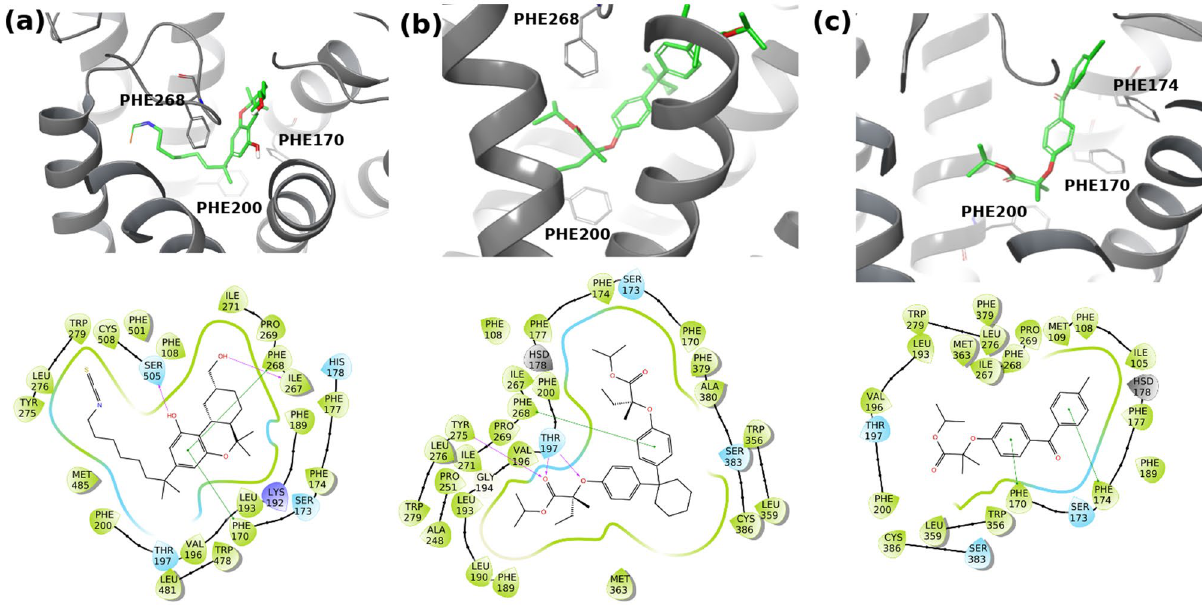
Figure 7. The 3D (upper panel) and 2D (lower panel) ligand interaction diagram of ( a ) the crystal structure of AM841 bound to the Cannabinoid receptor (CB1), ( b ) the potential binding mode of Clinofibrate bound to CB1; and ( c ) the potential binding mode of Fenofibrate bound to CB1. Figure 6 was generated with Maestro 9.2, the Schrodinger suite: https:// www. schro dinger. com/ produ cts/ maest